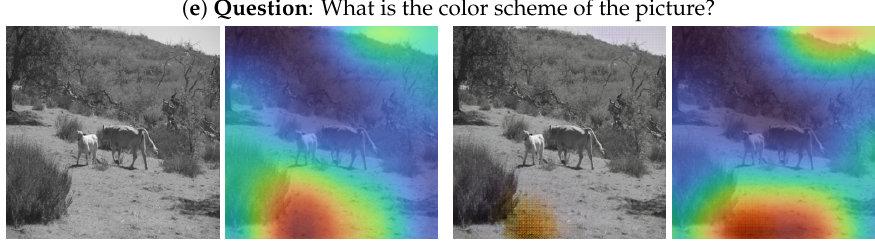
Figure 3. Examples of G ’s output for color-based questions from the VQAv1 [3] validation set. Left: original image I and the corresponding attention map M . Right: Generated counterfactual image I (cid:48) and the corresponding attention map M (cid:48)